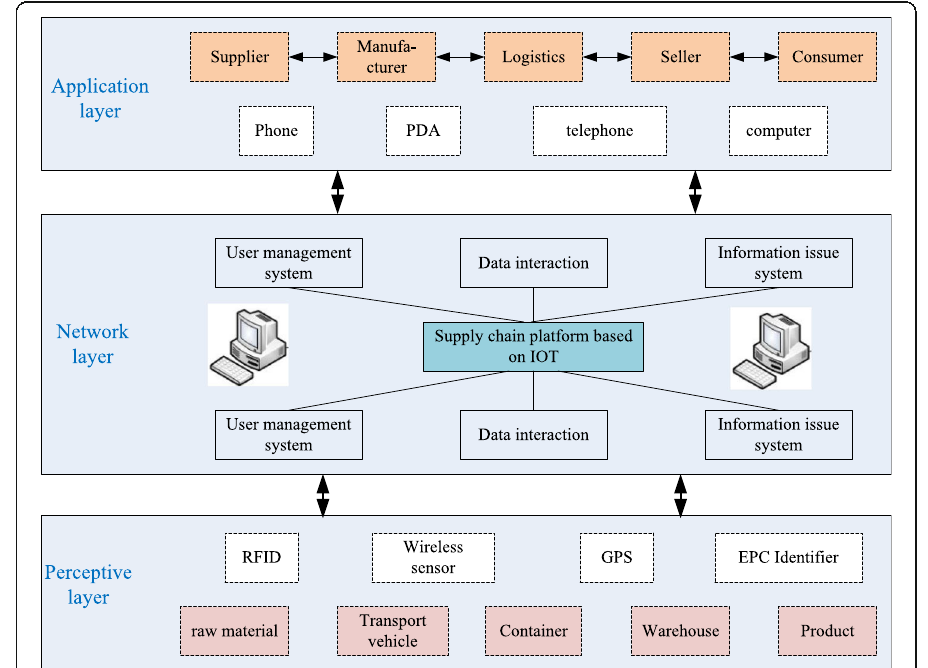
Fig. 1 The information sharing platform based on the Internet of things